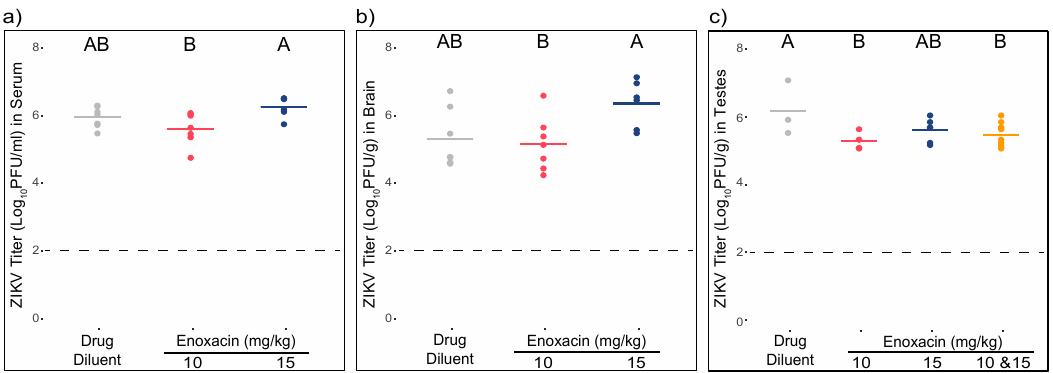
Figure 4. Treatment with enoxacin following high-titer infection suppresses ZIKV replication in mouse testes but not in sera or brain. Individual (dots) and mean (line) ZIKV titers of mice treated with the drug diluent or enoxacin from ( a ) sera, ( b ) brain, and ( c ) testes. Sample sizes for each treatment are listed in Table 2 and statistical analysis is described in the text. Values that do not share a letter are significantly different ( p < 0.05).